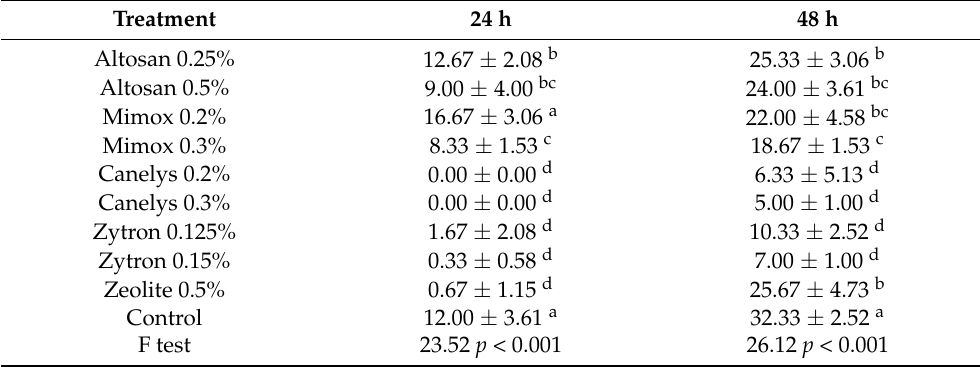
Table 1. Influence of in vitro tested substances on rust conidia germination at different time intervals.